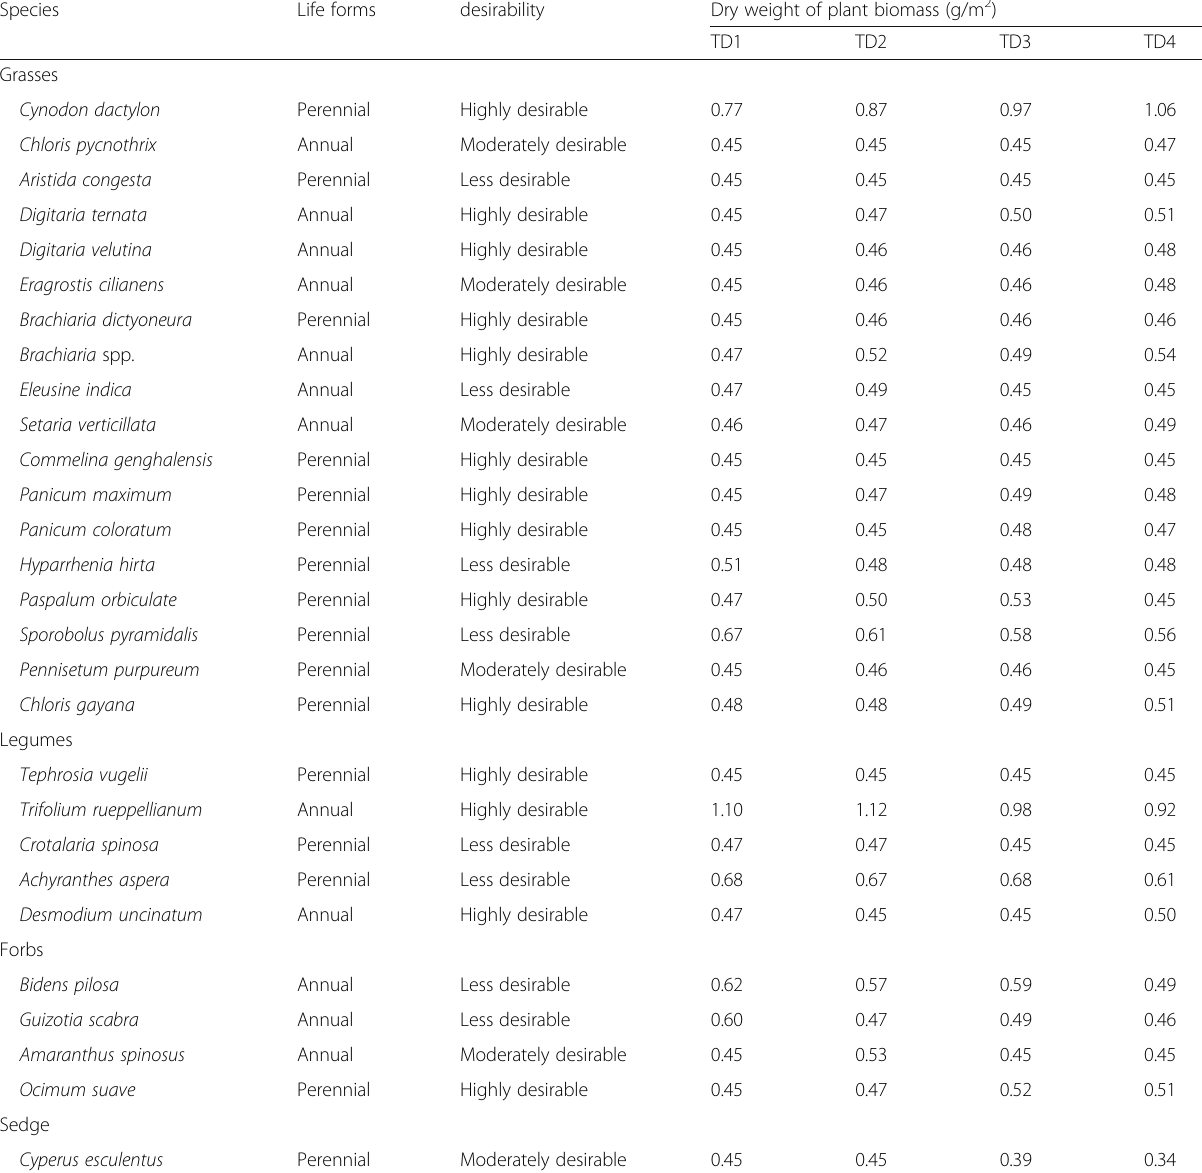
Table 3 Effects of grazing intensity on life forms, desirability and dry weight (g/m 2 ) of different herbaceous species in Chagni Ranch, Northwest Ethiopia Species